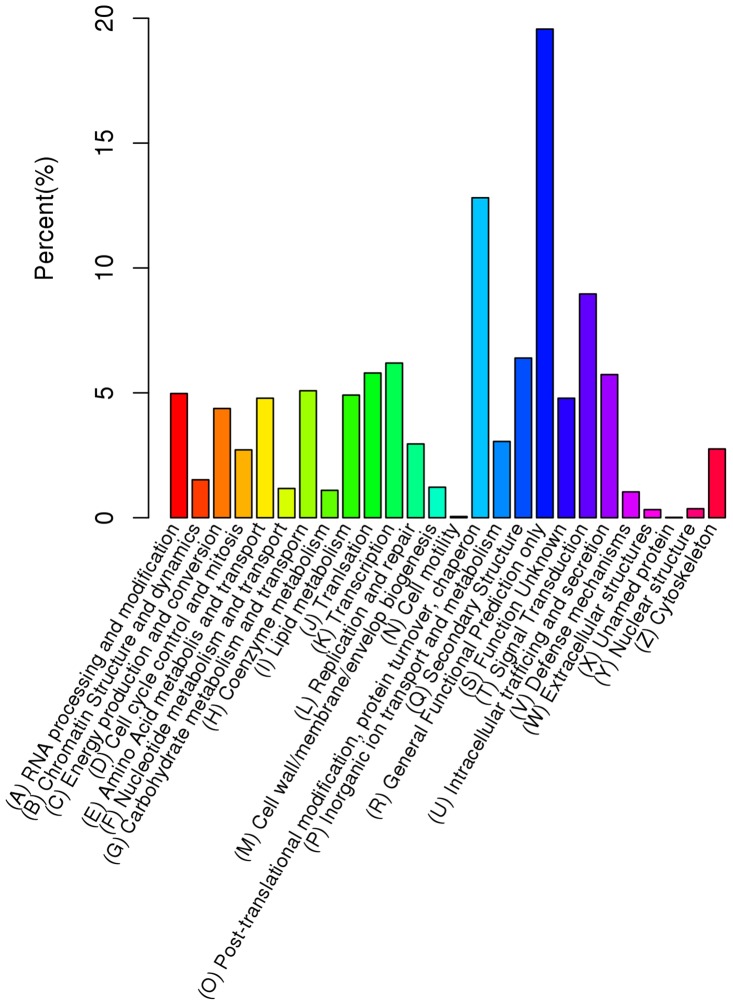
Distribution of the assembled unigenes across the KOG categories.